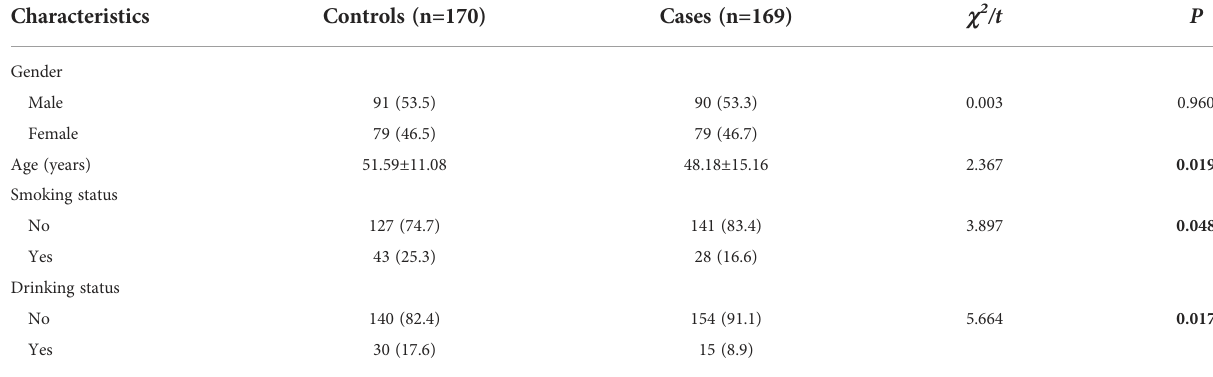
TABLE 2 General Characteristics of theSubjects.